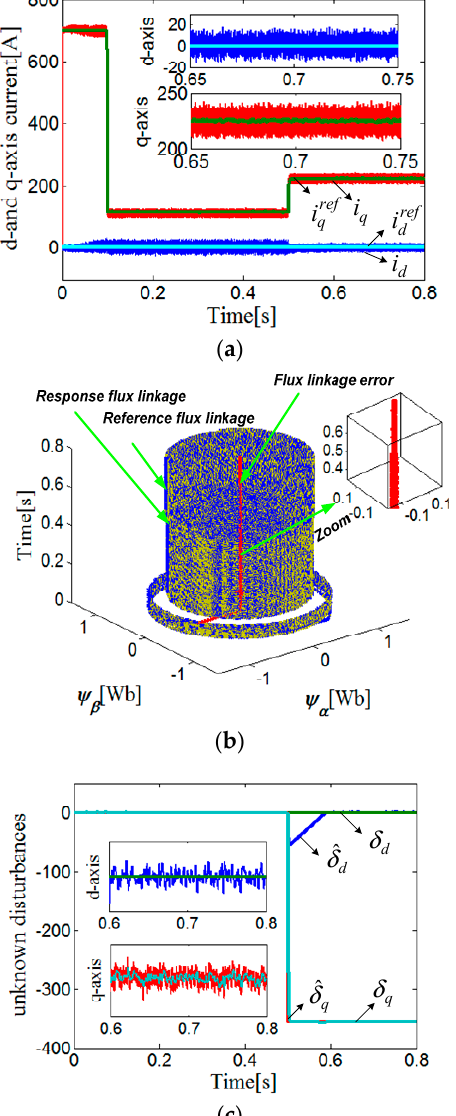
Figure 7. Simulation results of the RNPCC method under flux linkage parameter perturbation . ( a ) d ‐ and q ‐ axis current responses and references; ( b ) three ‐ dimension rotor flux trajectories; ( c ) disturbance and q -axis current responses and references; ( b ) three-dimension rotor flux trajectories; ( c ) disturbance estimation results. estimation